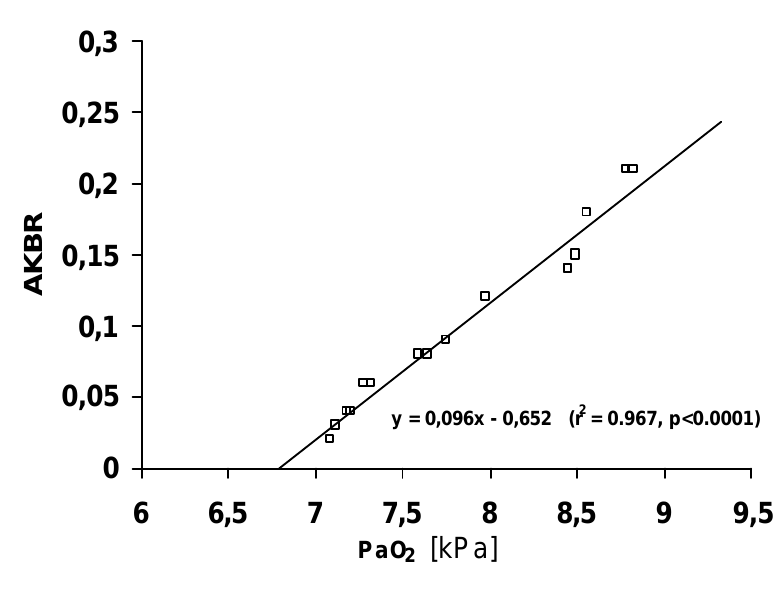
Figure 2. The relationship between arterial ketone body ratio (AKBR) and arterial oxygen tension (PaO 2 ) in patients with Carcinoma hepatis metastaticum and chronic cardiogenic circulatory insufficiency (group